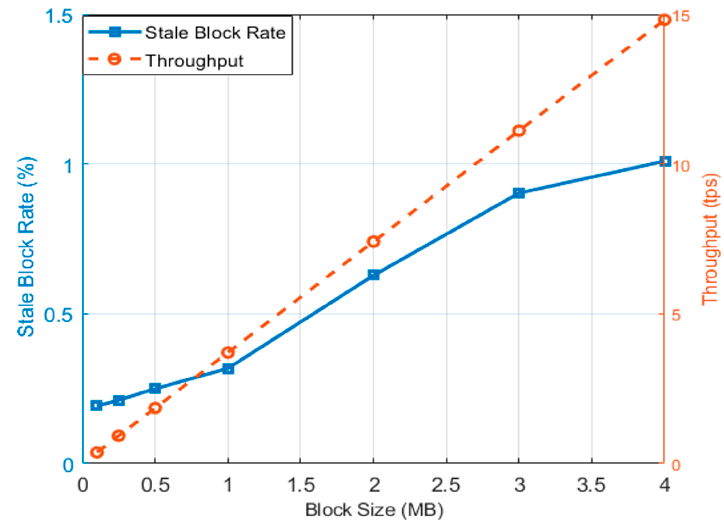
Figure 5. Effect of block size 𝛿 on stale block rate and throughput.